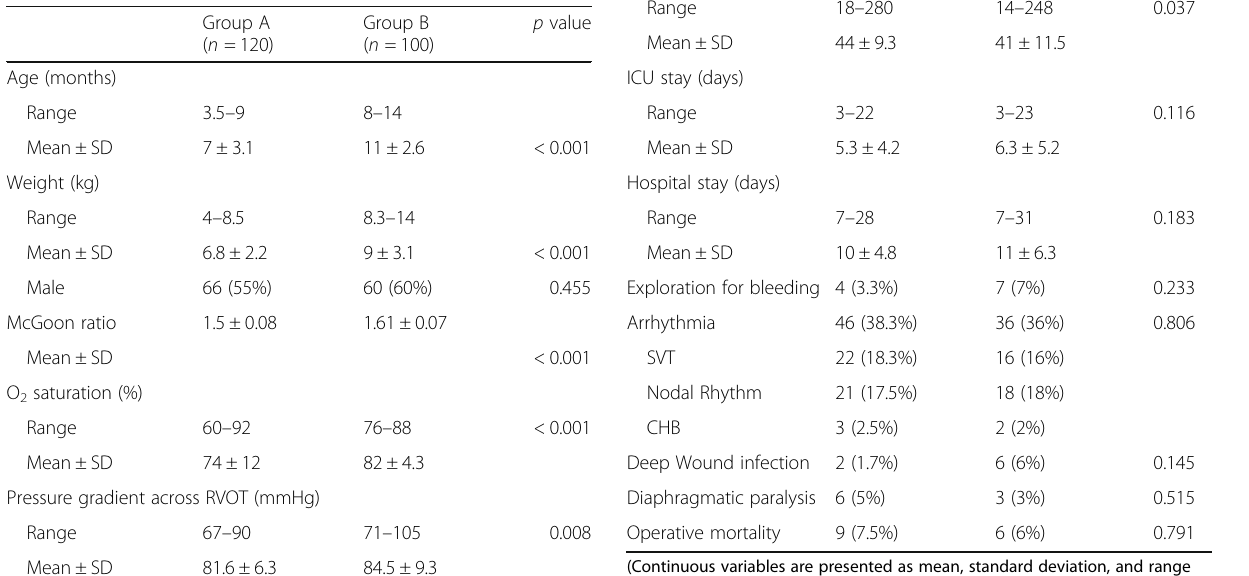
presented as mean, standard deviation and range and categorical data as number and percent) ( RVOT right ventricular outflow tract)